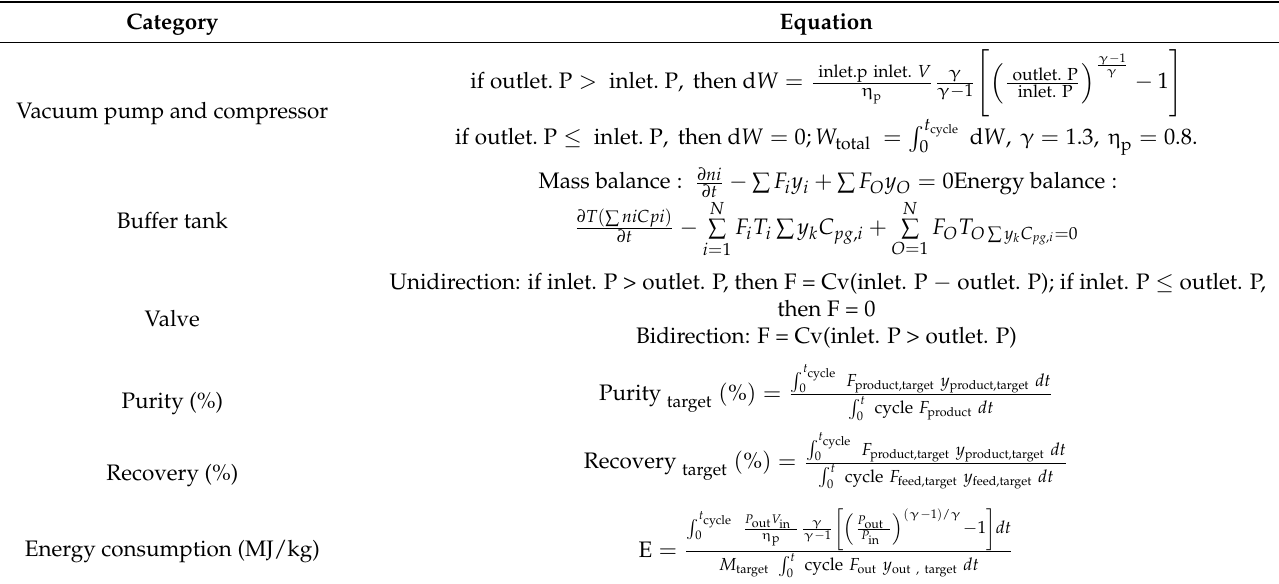
Table 3. Model equation of compressor, buffer and